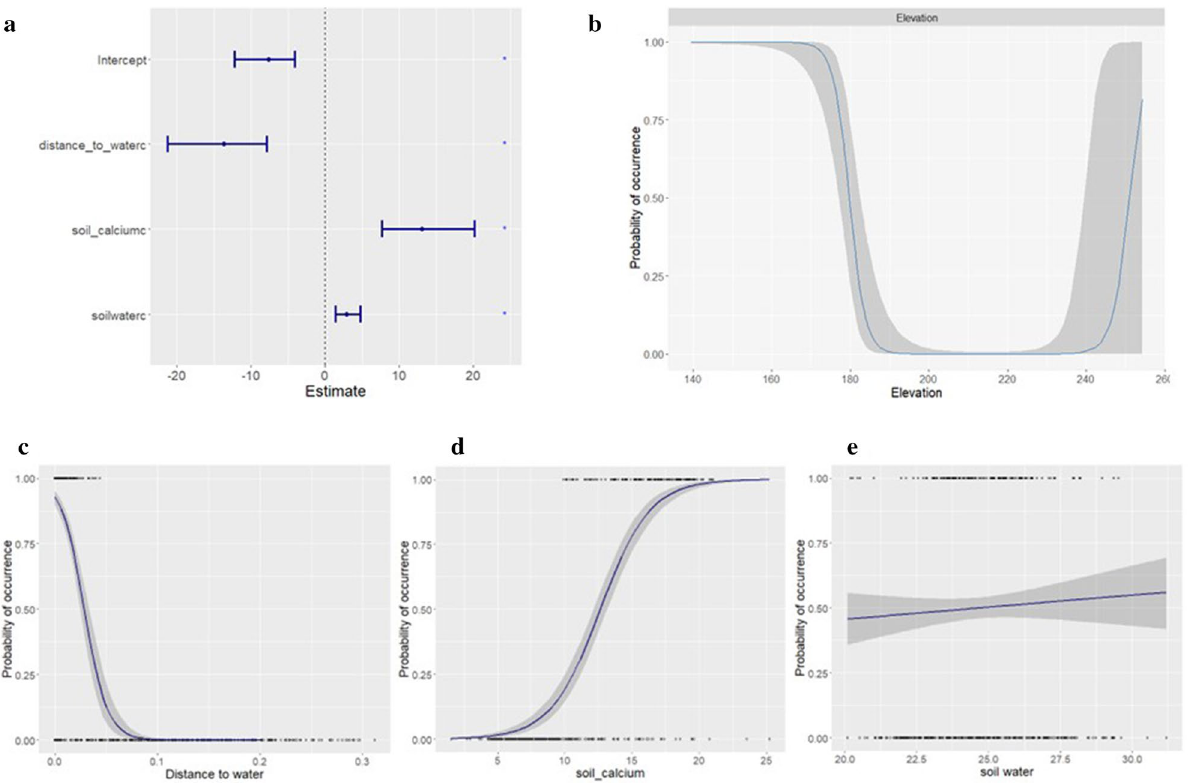
Figure 3. ( A ) The fixed effect and credible intervals for the linear covariates, ( B ) the smoothed fits of elevation (in m in x-axis) and linear fits of: ( C ) distance to water (in km in x-axis), ( D ) soil calcium (in cmolc/kg in x-axis), ( E ) soil water (in v% in x-axis) variables. The y-axis shows the estimated probability of presence. The shaded grey polygons represent 95% credible intervals.